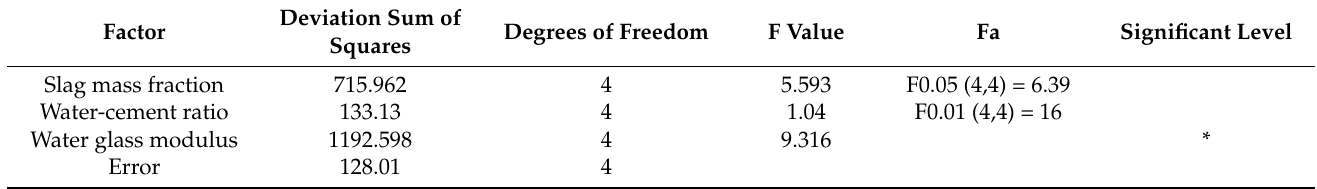
Table 9. Variance analysis table of 28 − day compressive strength results of orthogonal test.